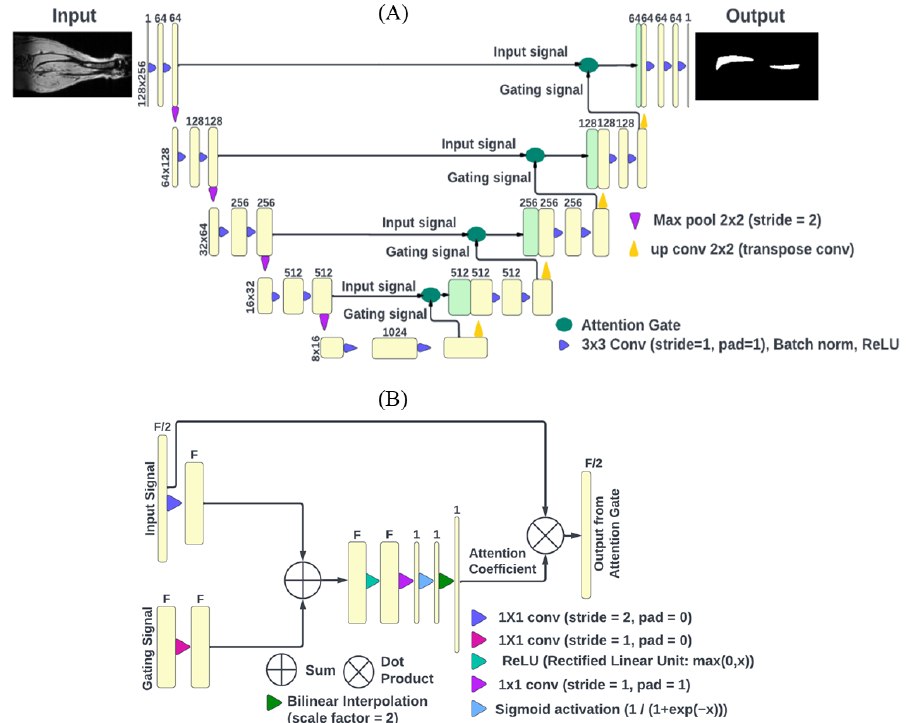
Figure 2. ( A ) Attention U-net architecture with ( B ) attention gate diagram: the black arrows indicate the workflow direction; yellow boxes depict the operation output (with the image dimensions (height × width) on the side and the number of applied filters shown on top), and green boxes correspond to output from the attention gate ( B ); colored triangles denote operations described in the legends. Output from the attention gate (green box) and up convolutions (yellow triangle) are concatenated (merged boxes). Attention coefficients are 2D arrays obtained from the input 2D MRI slices by the set of operations shown in ( B ).